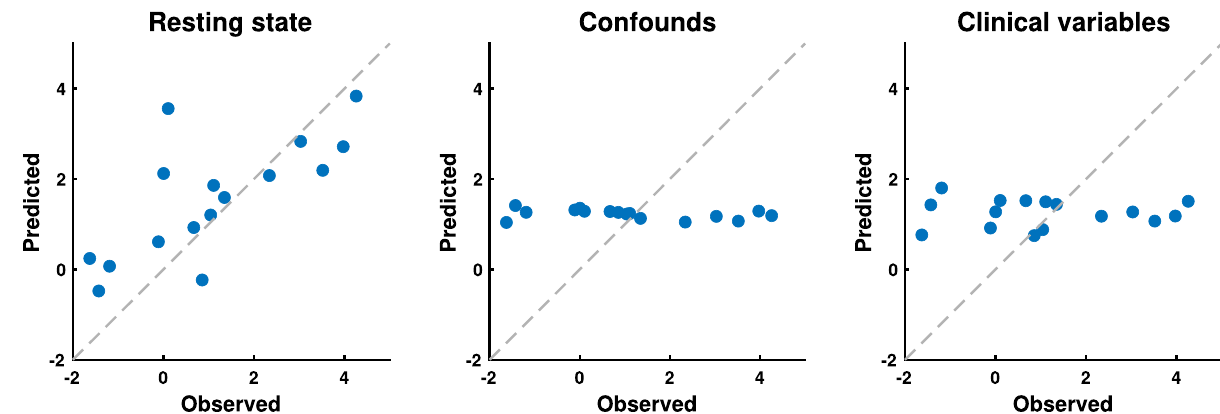
Fig. 4 Predicting noxious-evoked response amplitudes from non-noxious data. For all plots, each blue dot represents an out-of-sample cross-validated prediction for a single neonate ( n = 18), and the dashed grey line is the y = x line along which perfect predictions would lie. The x -axis is the observed noxious-evoked response amplitude (after cross-validated confound regression), and the y -axis is the predicted noxious-evoked response amplitude. Predictions were generated based on three sets of predictors: (left) the resting-state network amplitudes; (middle) resting-state imaging confounds, which included head motion, CSF amplitude, and white matter amplitude; and (right) clinical variables, which included age (gestational, postmenstrual, and postnatal), birth weight, total brain volume, and sex. Source data are provided as a Source Data fi le. were tested in a multivariate model and were also not predictive Examining the correlation polarity of each network individu- (Fig. 4; Table 2). The lack of association between noxious-evoked ally, eight of nine networks were positively correlated with response amplitudes and resting-state imaging confounds suggest noxious-evoked response amplitudes, with the single negative that the predictive value of RSN amplitudes was not mediated by correlation being negligible (executive control network, r = – 0.03) undesirable confounding features of resting-state data, but rather (Supplementary Fig. 4a). Examining the predictive value of each by the correspondence between resting-state and noxious-evoked network individually, only the SMN exhibit notable predictive brain activities. These brain function similarities could not be value, with a prediction performance ( R 2 = 0.60) comparable to our multivariate prediction model performance ( R 2 = 0.62) explained by the biologically interesting variables of age, BW, brain volume, or sex.